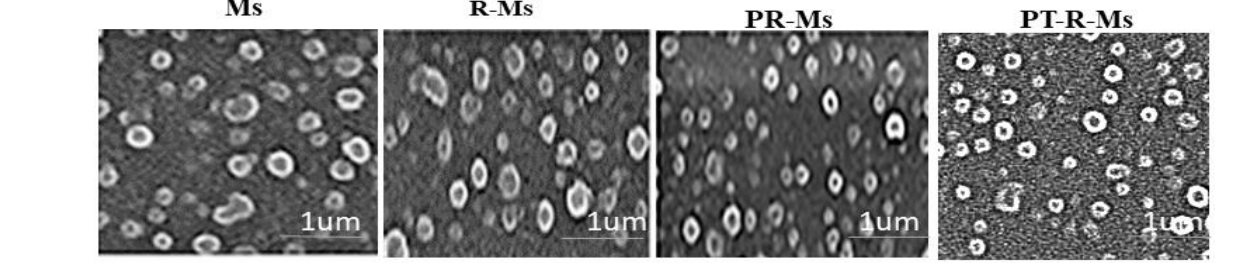
Figure 2. Representative TEM images of Ms, R-Ms, PR-Ms, and PT-R-Ms. Table 2. Drug release kinetic modeling demonstrates the potential drug release Table 1. Nomenclature, chemical composition, and characteristics of the different polymeric micelles used in this work. Formulation Code